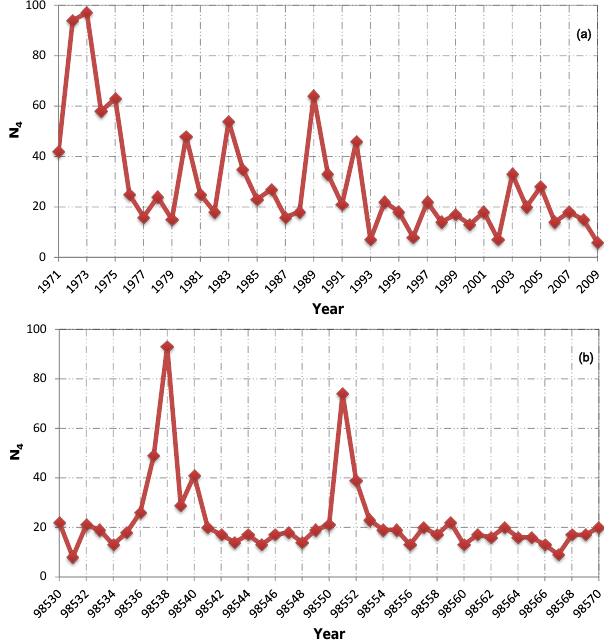
Fig. 9. (a) Numbers of M ≥ 4 earthquakes per year N4 in north- ern California for the period 1970 to 2009. (b) Numbers of M ≥ 4 earthquakes per year N4 for a typical 40yr period obtained from our composite